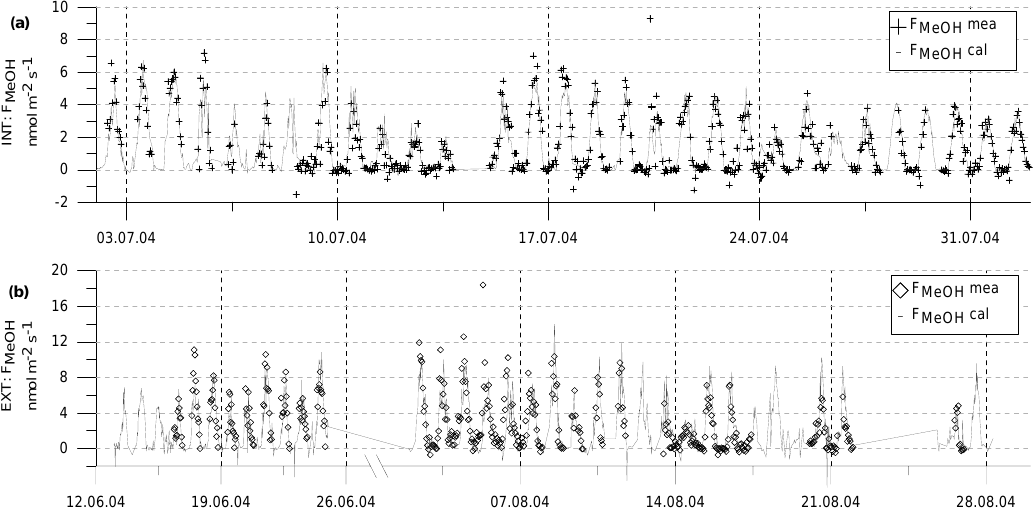
Fig. 12. (a) Methanol flux ( F MeOH ) of the intensive field: measured (mea) and calculated (cal) by mean of the multiplicative approach. Correlation between measured and calculated methanol flux of the intensive field ( y =0.80 x +0.28; r 2 =0.79). (b) Methanol flux ( F MeOH ) of the extensive field: measured (mea) and calculated (cal) by mean of the multiplicative approach. Correlation between measured and calculated methanol flux of the extensive field ( y =0.79 x +0.79; r 2